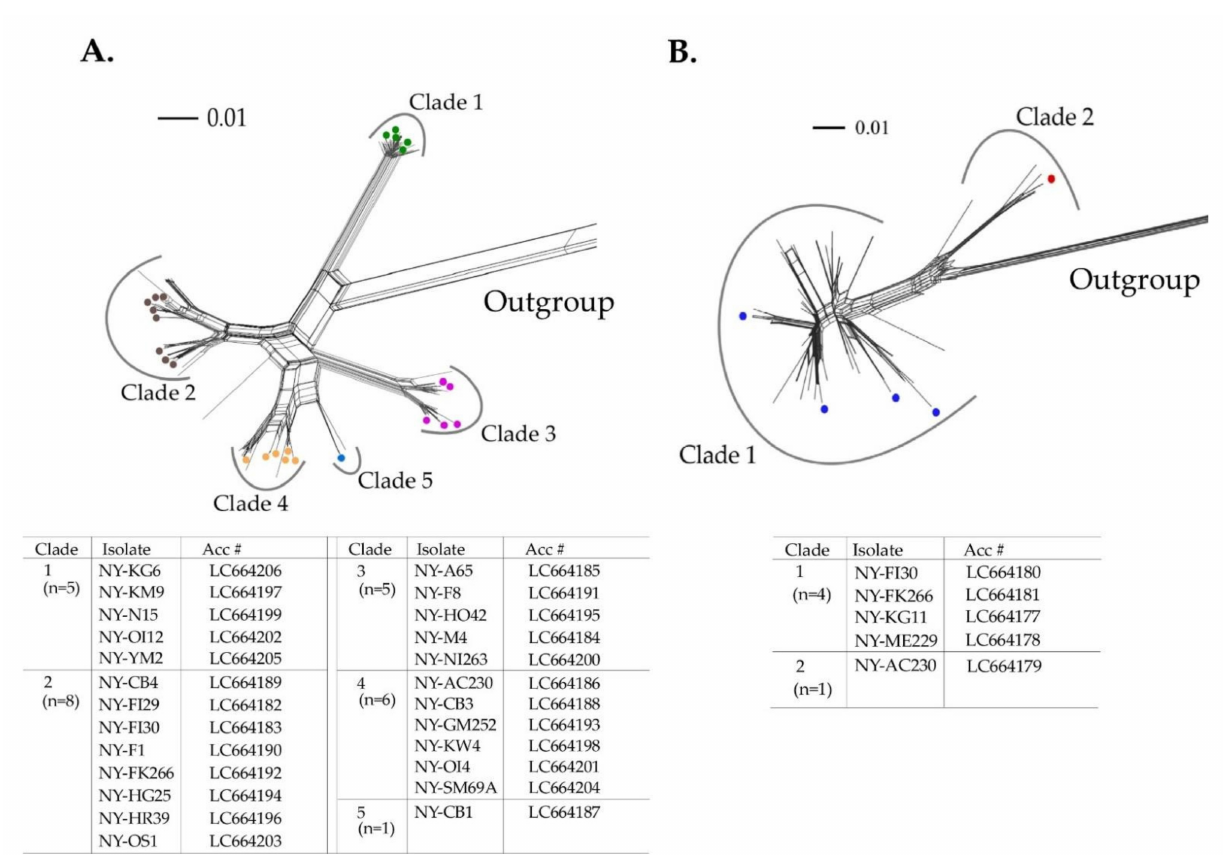
Figure 2. Phylogenetic networks of the nucleotide sequences of the complete coat protein (CP) coding regions from the plasmid clones of narcissus viruses. ( A ) Narcissus late season yellows virus (NLSYV). The nucleotide sequences of CP coding regions of Japanese yam mosaic virus (JYMV) [46], narcissus yellow stripe virus (NYSV) [26], scallion mosaic virus (ScaMV) [48], and turnip mosaic virus (TuMV) [47] in the TuMV phylogenetic group were used as outgroup taxa. ( B ) Narcissus degeneration virus (NDV). The nucleotide sequences of CP coding regions of cyrtanthus elatus virus A (CyEVA) [27], iris severe mosaic virus (ISMV) [49], onion yellow dwarf virus (OYDV) [50], and shallot yellow stripe virus (SYSV) [51] in the OYDV phylogenetic group were used as outgroup taxa. Dots in each clade show the isolates whose genomic sequences were fully sequenced. The full genomic sequences of the isolates determined in this study are listed in the tables below the phylogenetic networks of NLSYV and NDV. Acc # are also listed in the tables. The NY-CB1 isolate was found to have recombination site in CP coding sequence (see Section 3.6. Inference of